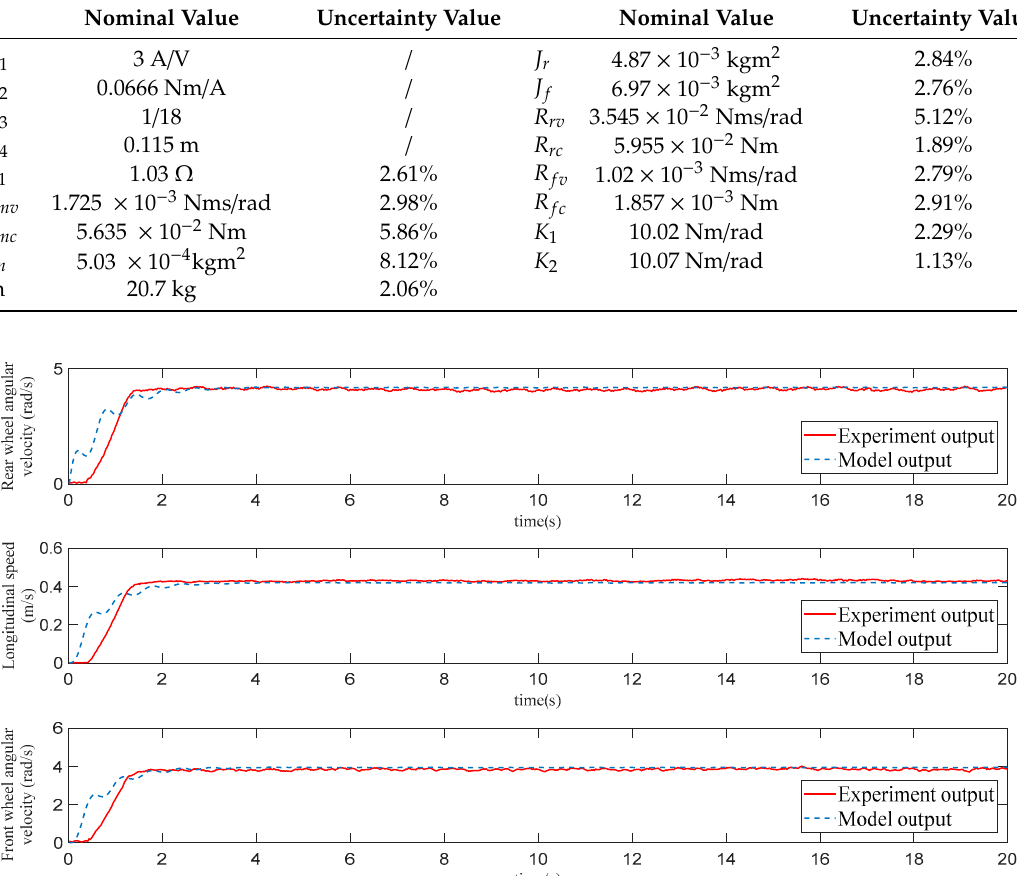
Figure 5. Model outputs versus experiment outputs.